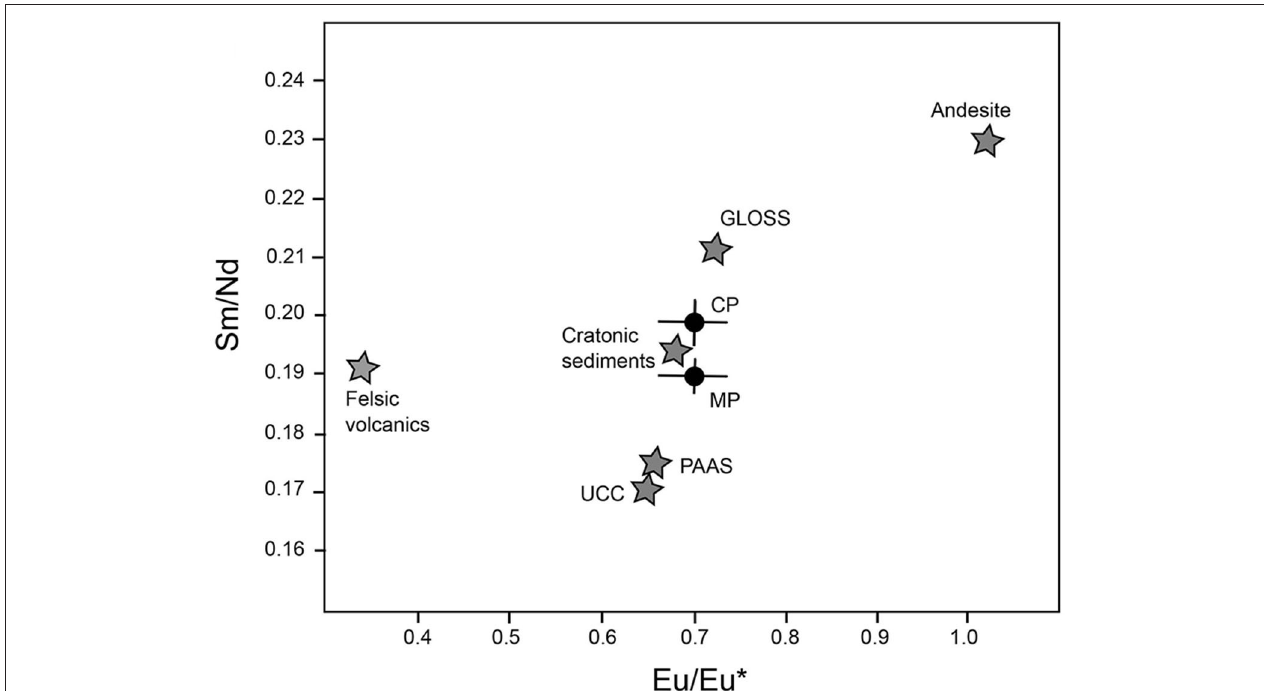
FIGURE 11 | Eu/Eu* vs. Sm/Nd binary plot showing average standard lithologies. Circles are CP and MP palaeosols. Felsic volcanics and Cratonic sediments in Condie (1993); PAAS and Andesite in Taylor and McLennan (1985); GLOSS in Plank and Langmuir (1998).